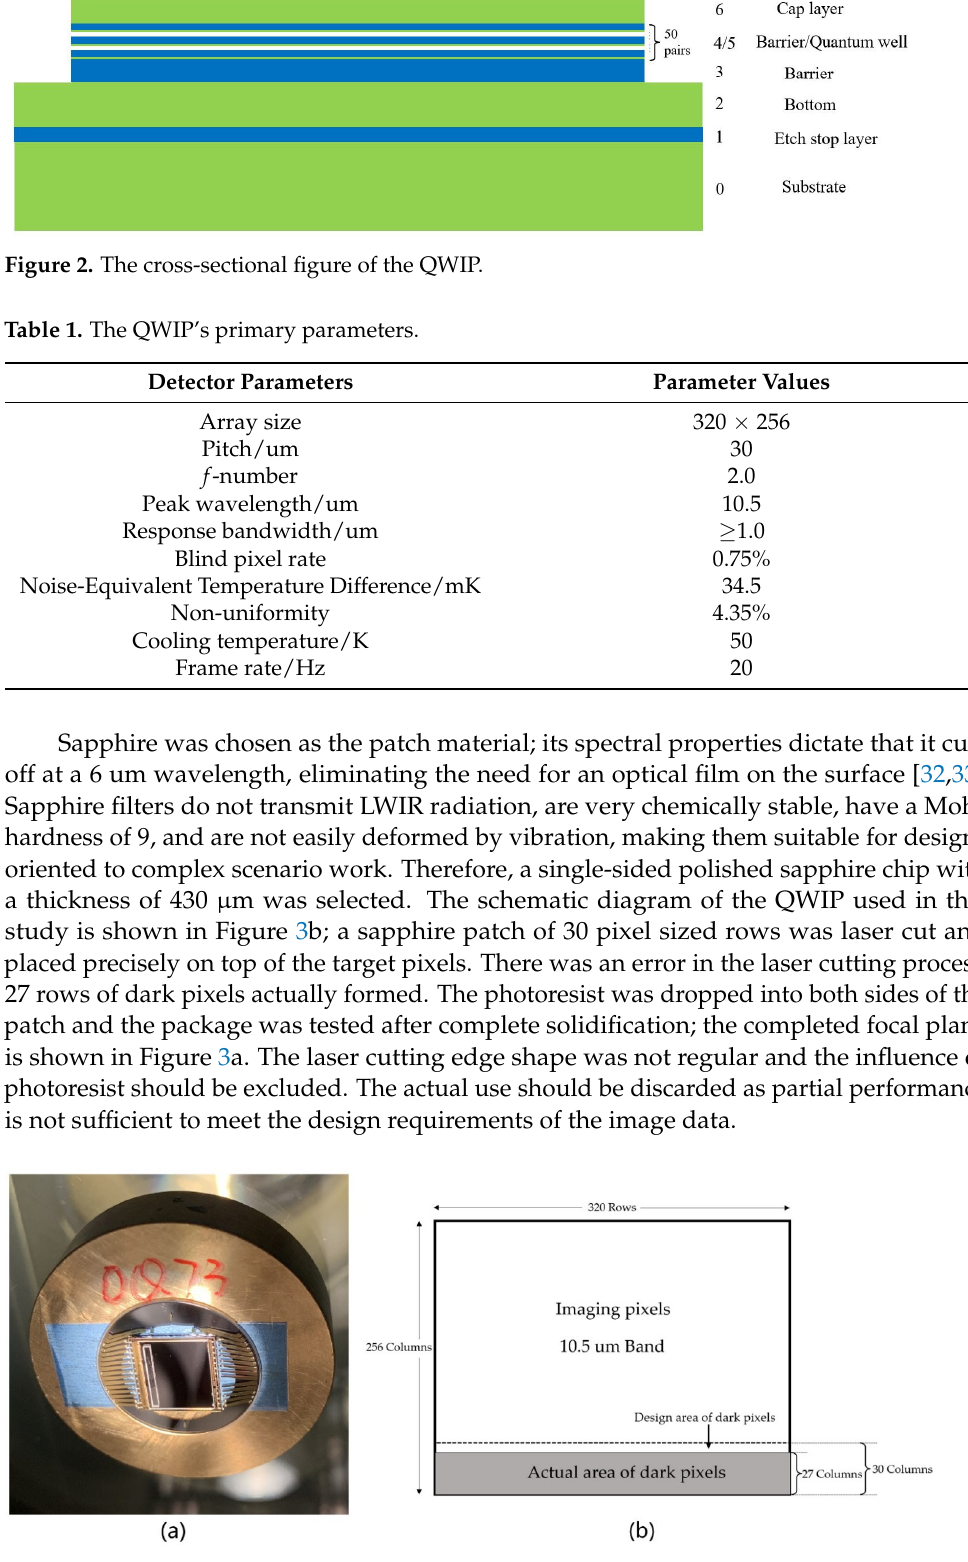
Figure 3. Fabrication of QWIP with dark pixels; ( a ) QWIP with dark pixels; ( b ) design schematic of QWIP with dark pixels. QWIP with dark